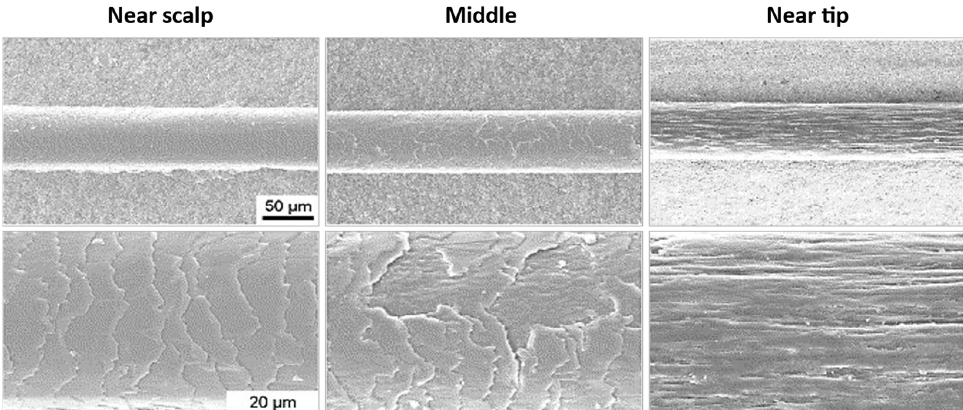
Figure 5. SEM images of a virgin hair fiber at three locations: near the scalp, in the middle of the fiber and near the tip. Adapted from reference [23] with permission from Elsevier.